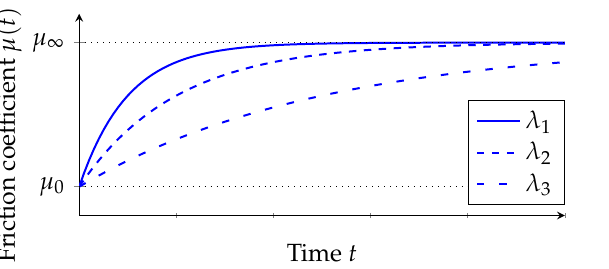
Figure 4. Exemplary course of the coefficient of friction µ ( x , y , t ) over time at a certain position x 1 , y 1 for constant values of µ ∞ , µ 0 , a temporal constant local surface pressure ¯ p ( x 1 , y 1 ) and different values of λ , where λ 1 > λ 2 > λ 3